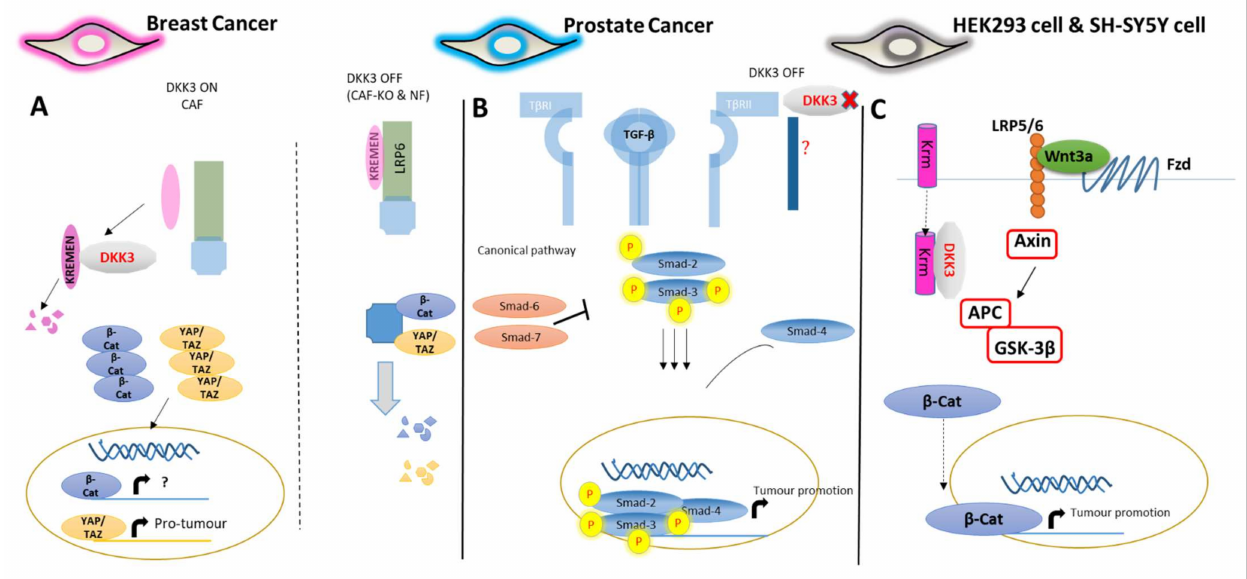
Figure 3. Potential mechanisms of action of Dkk-3 in different cancers. (A) Intracellular Dkk-3 in breast cancer-associated fibroblasts (CAFs) destabilizes Kremen, leading to the potentiation of YAP/TAZ and β -catenin signaling, adapted from Ferrari et al. (2019). ( B) Dkk-3 secreted by WPMY-1 prostate stromal cells reduces TGF- β -dependent invasion of prostate cancer cells. The Dkk-3 receptor remains unidentified. ( C ) Proposed mechanism of action of Dkk-3 based on results from human embryonic kidney (HEK293) and neuroblastoma (SH-SY5Y) cell line studies. Dkk-3 potentiates